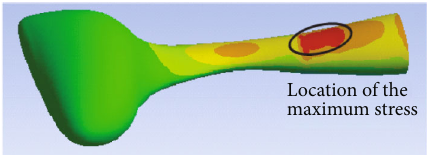
Location of the maximum stress